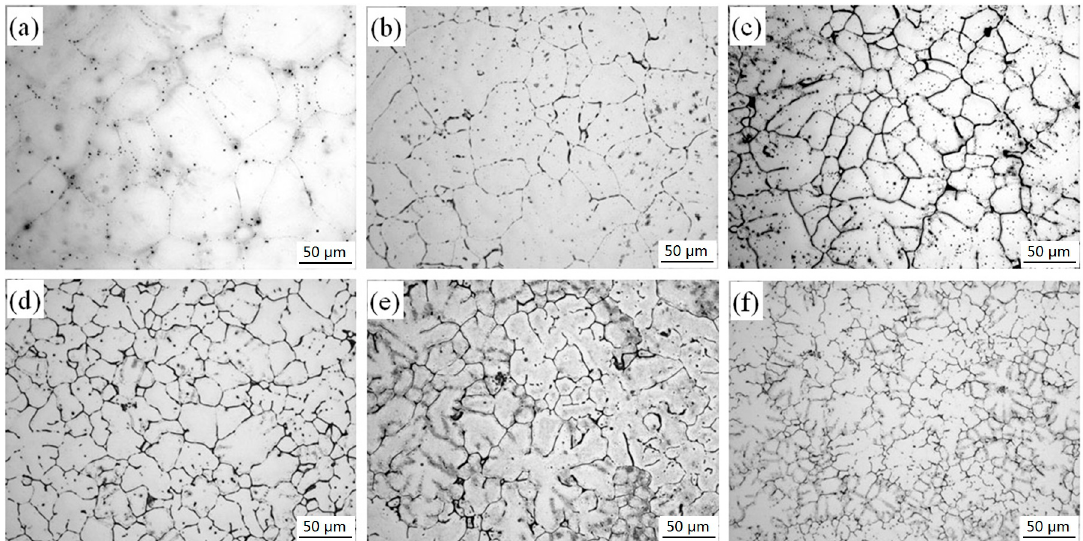
Figure 1. Optical micrographs of Mg–2.0Zn–0.5Zr–xGd alloys: ( a ) x = 0; ( b ) x = 1; ( c ) x = 2; ( d ) x = 3; ( e ) x = 4; ( f ) x = 5.